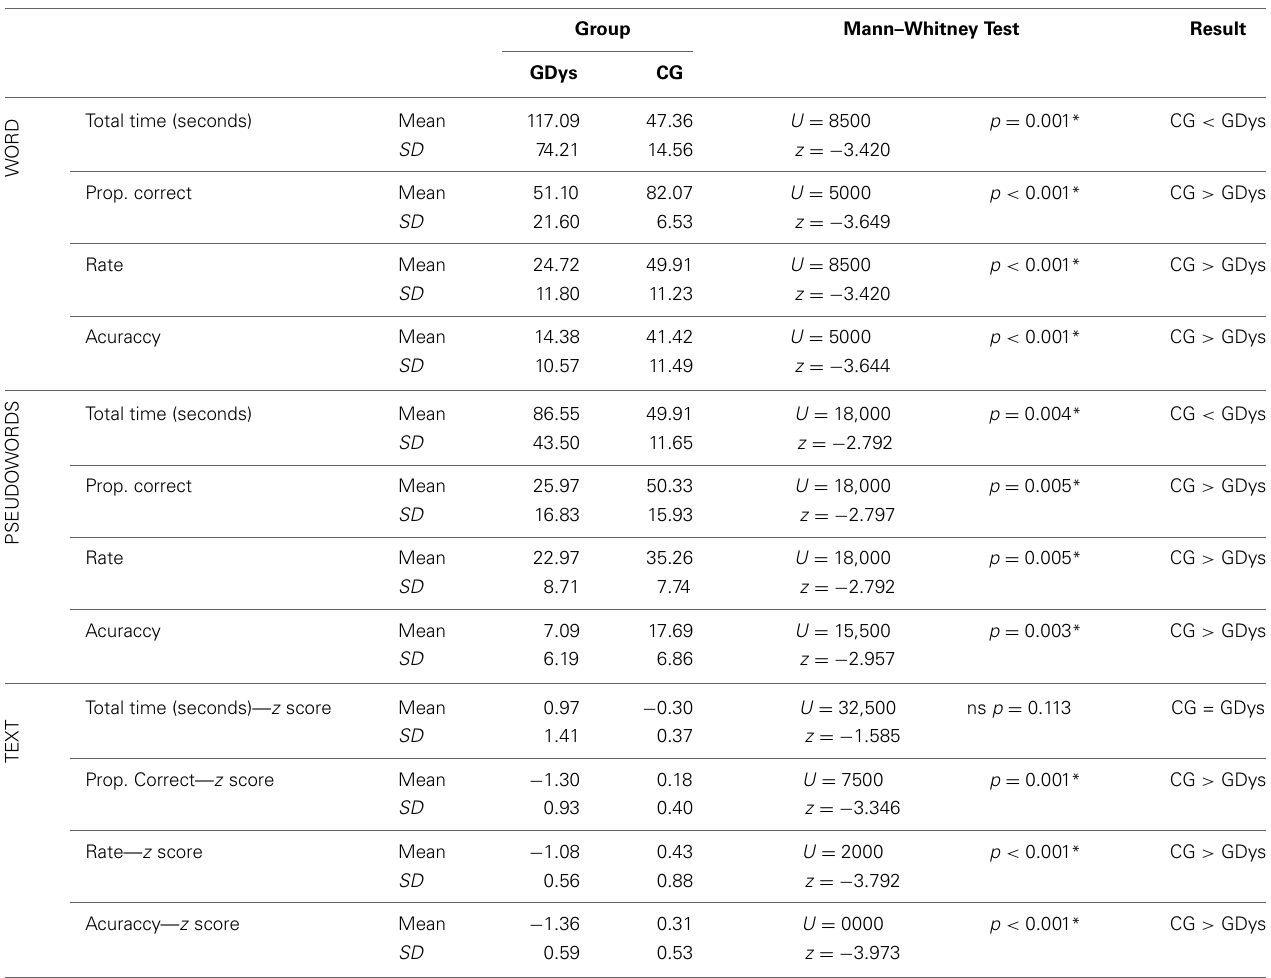
Table 1 | Comparison of performances obtained in tests of reading